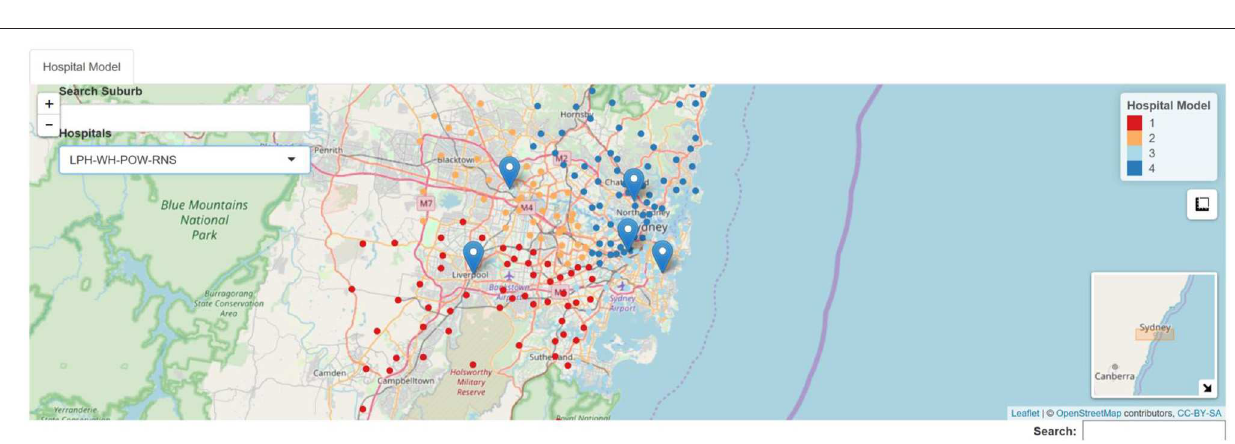
follow by model 6 (LPH/POW/RNS − 8982 cases) and by model 1 (RPA/LPH/WH − 8559 cases). The maximum